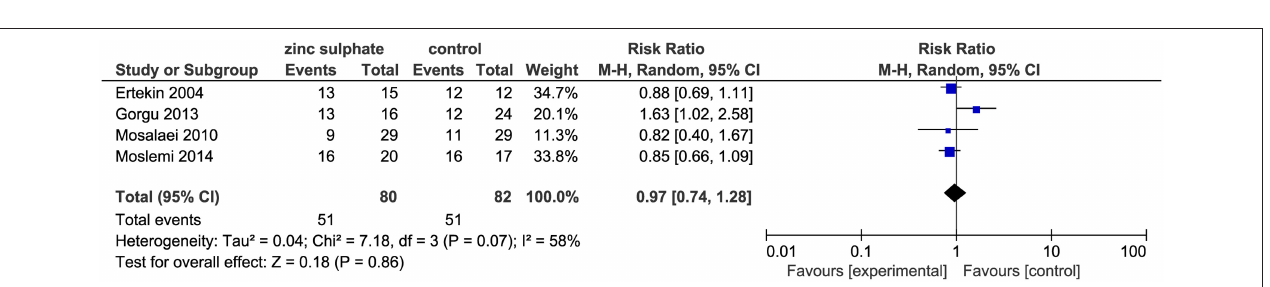
FIGURE 3 | Meta-analysis of incidence of oral